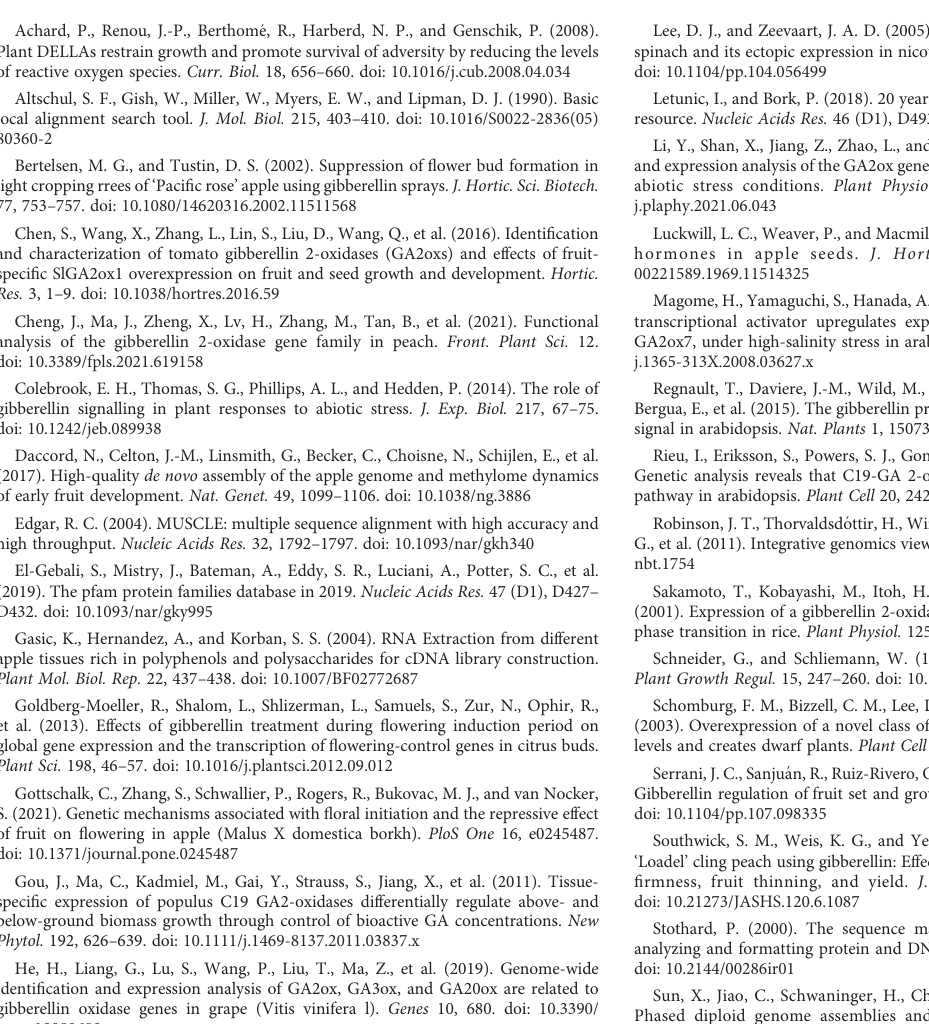
SUPPLEMENTARY FILE 8 Sequence alignment of the 16 GA2ox protein sequences from apple and other plants as shown in . Several sequences (MdGA2ox3A, -4B, -6A, -7A and -7B) were curated based on our transcriptome data and the ‘ Gala ’ genome.